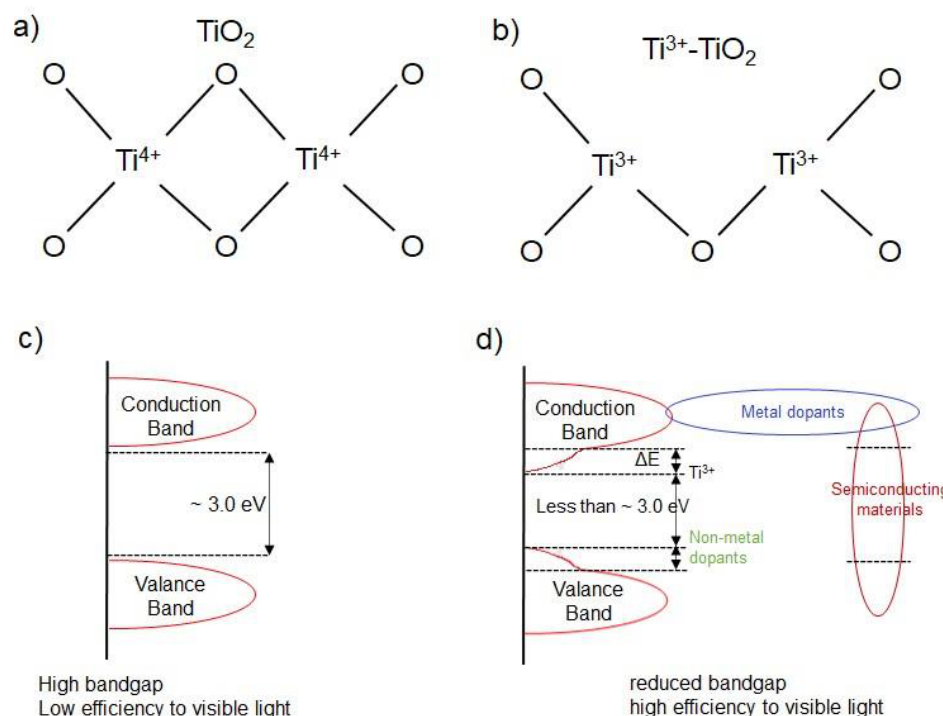
Figure 1. Schematic structures of ( a ) TiO 2 and ( b ) Ti 3 + –TiO 2 according to band positions of ( c ) TiO 2 and ( d ) Ti 3 + –TiO 2 modified with heterogeneous materials.